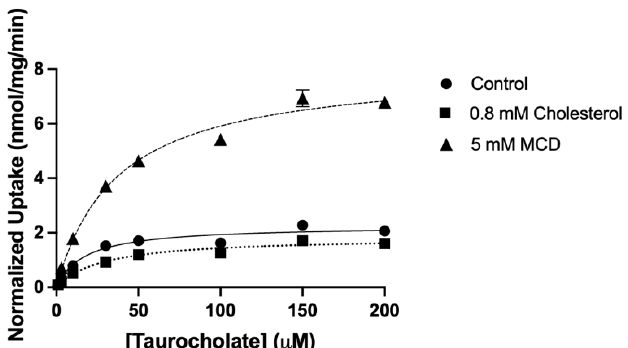
Figure 7. Normalized kinetics of NTCP-mediated taurocholate uptake after treatment with cholesterol or MCD. Uptake of increasing concentrations of taurocholate was measured at 37 °C for 15 s in NTCP- expressing HEK293 cells in a sodium-containing or sodium-free buffer, and corrected for protein. Net uptake was calculated by subtracting the uptake measured in choline chloride buffer from the uptake measured in a sodium chloride buffer and then correcting for NTCP surface expression. Values are the means ± SEM of at least three independent experiments performed in triplicates. Curves were fit with the Michaelis–Menten equation in GraphPad Prism.